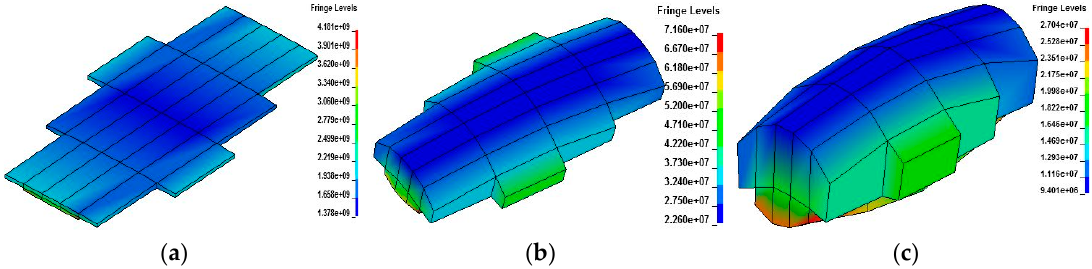
Figure 13. Pressure contours in blow-off impulse elements. ( a ) t = 0.0096 µs; ( b ) t = 1 µs; ( c ) t = 2 µs.